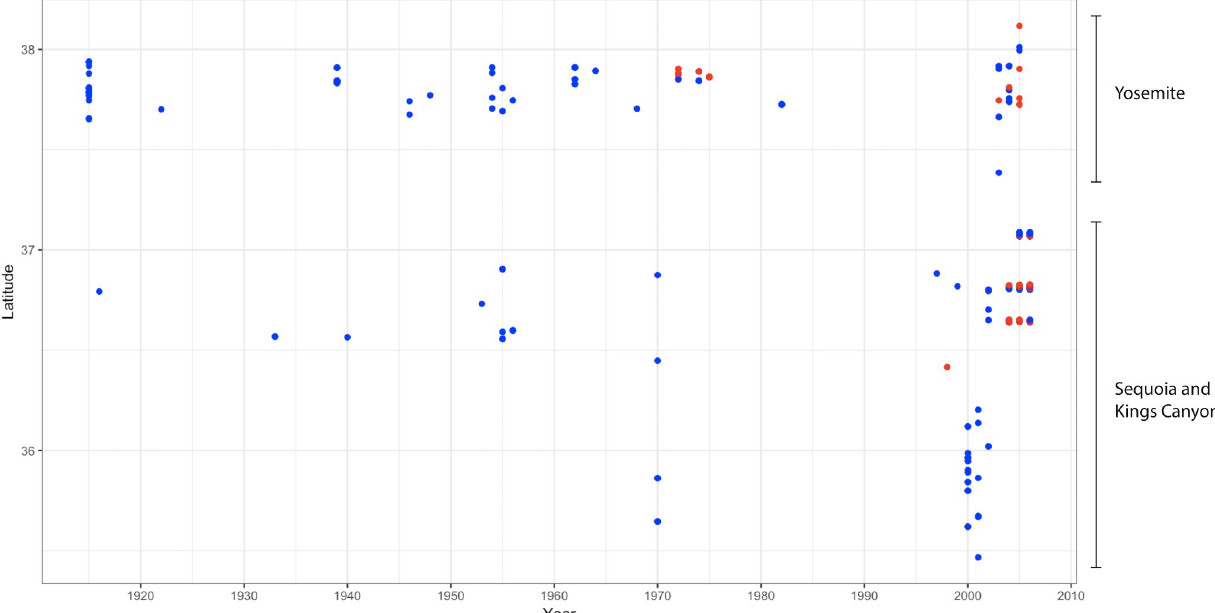
Fig 4. Chronology of Bd infected amphibians collected in and around Yosemite National Park (central Sierra Nevada) and Sequoia-Kings Canyon National Parks (southern Sierra Nevada).